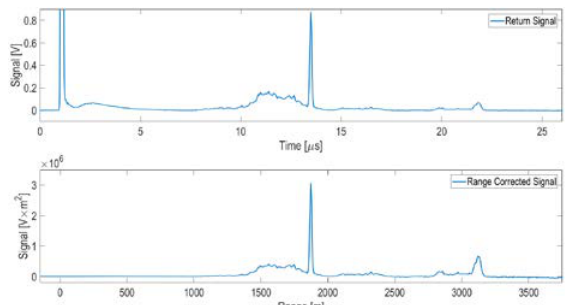
Figure 3. Sample profile of a near-filed cumulus cloud return at 2- µ m using MCT e-APD detection system (top) and the range corrected signal (bottom).